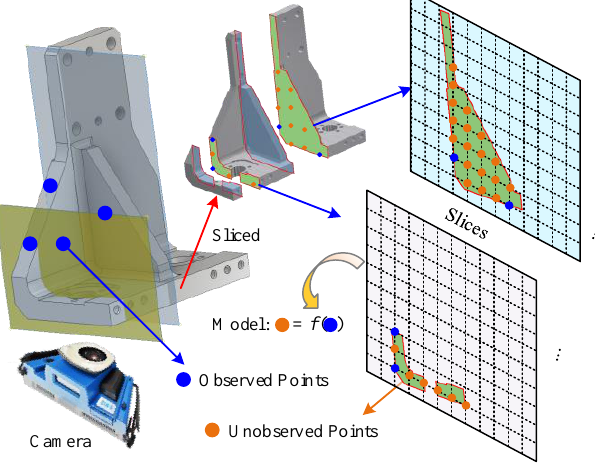
Figure 2. Measurement and modeling principle.